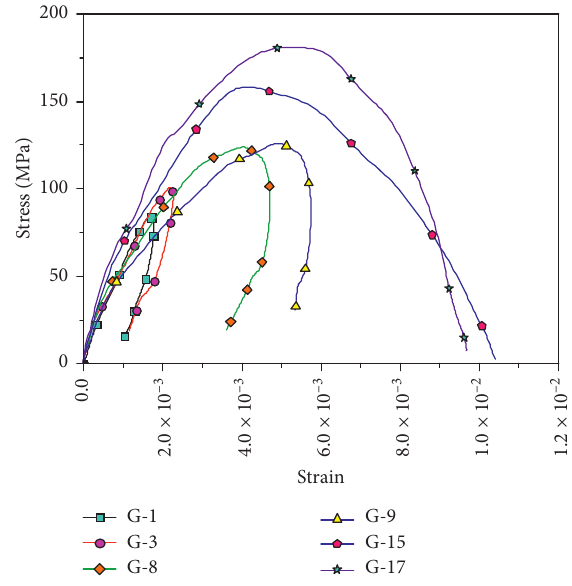
Figure 4: Three typical dynamic stress-strain